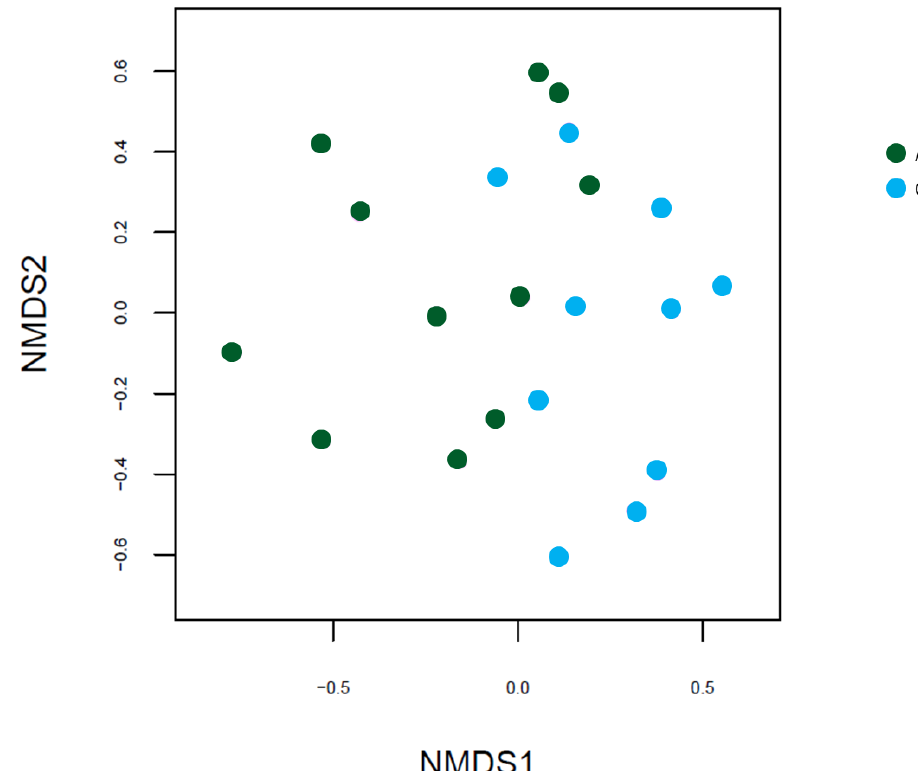
Figure 6. Alpha diversity of the UC and HC groups. UC, ulcerative colitis; HC, healthy control; A2, ulcerative colitis patient group; C2, healthy control group.